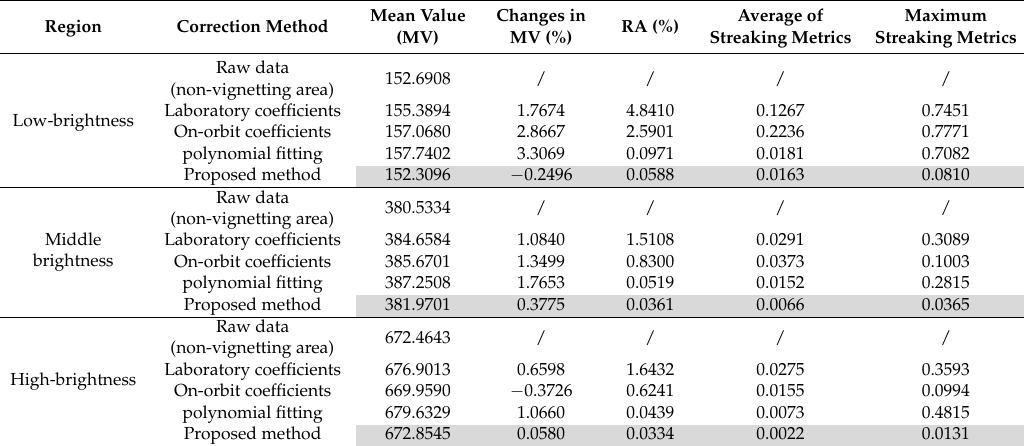
Table 2. Comparison of quantitative values for the